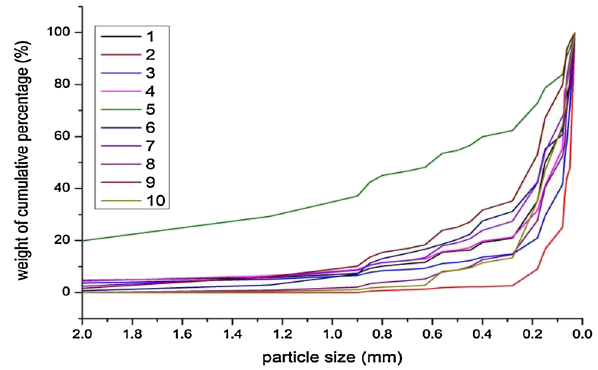
Fig. 5 The accumulation curve of cuttings weight